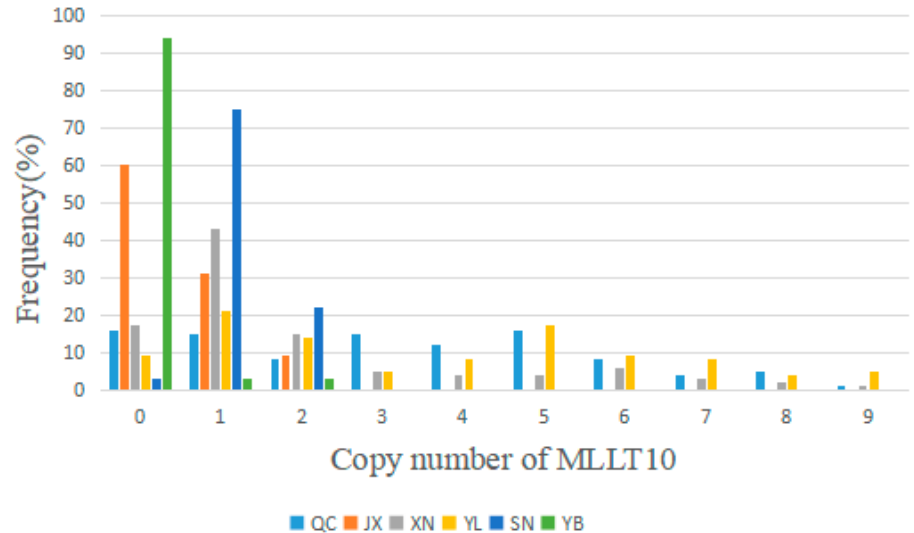
Figure 4. The frequency of CNV in six Chinese cattle breeds. Distribution of different copy number variants of the MLLT10 gene in 6 different Chinese yellow cattle breeds. Table 2. Correlation analysis between copy number variation of the MLLT10 gene and Chinese yellow cattle growth traits.